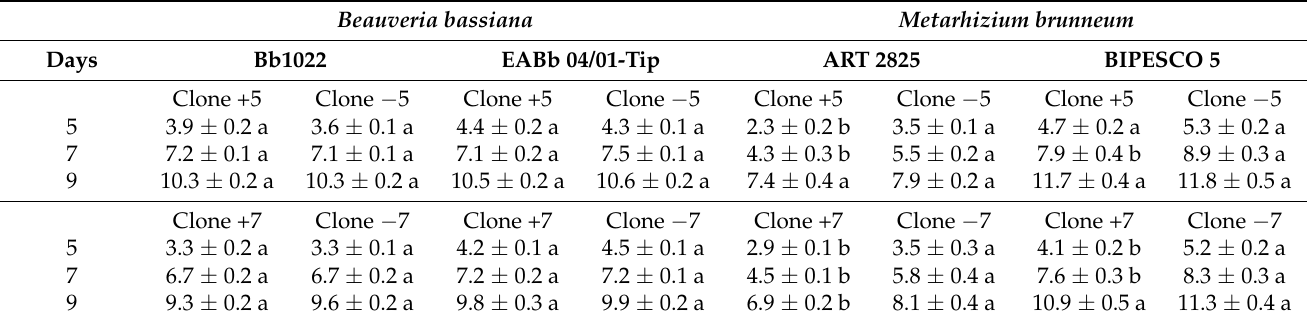
Table 2. Radial growth diameters (cm ± SE) of Beauveria bassiana and Metarhizium brunneum from dead wheat aphid ( Sitobion avenae ) clones with and without bacterial secondary symbionts. Beauveria bassiana Metarhizium brunneum ART